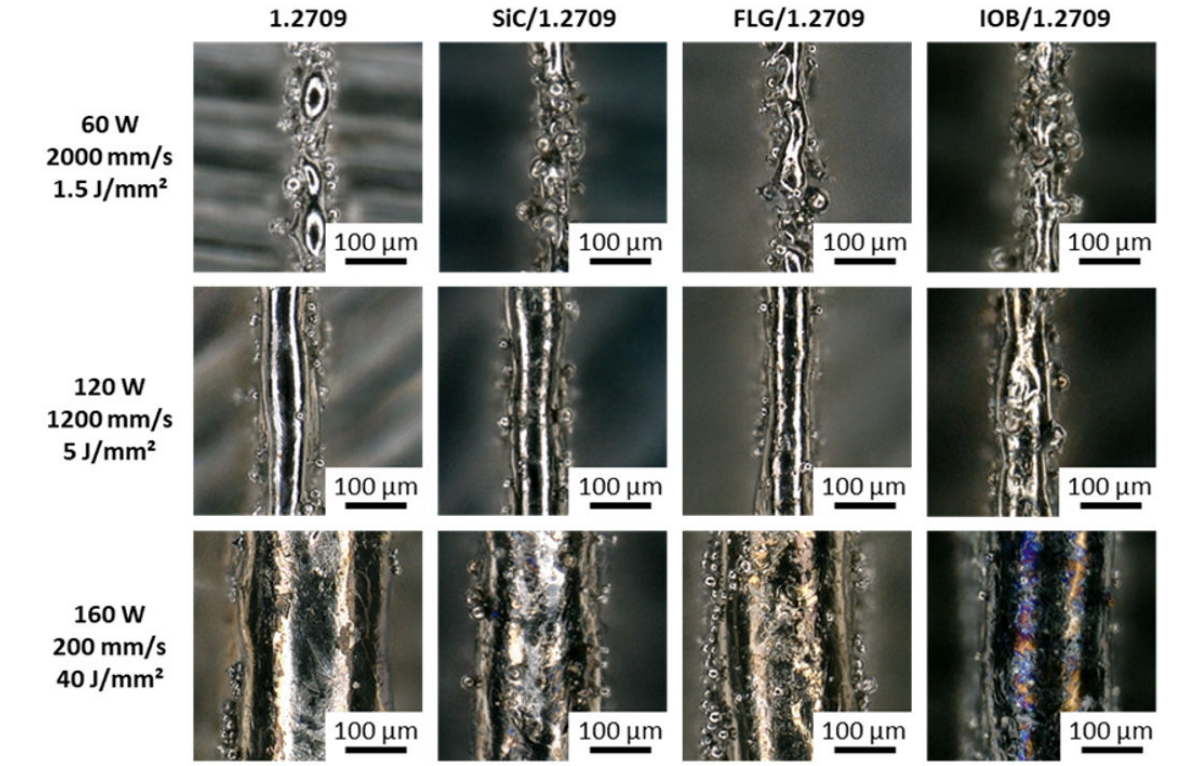
Figure 7. Top view of the single track of 1.2709, SiC/1.2709, FLG/1.2709, and IOB/1.2709.